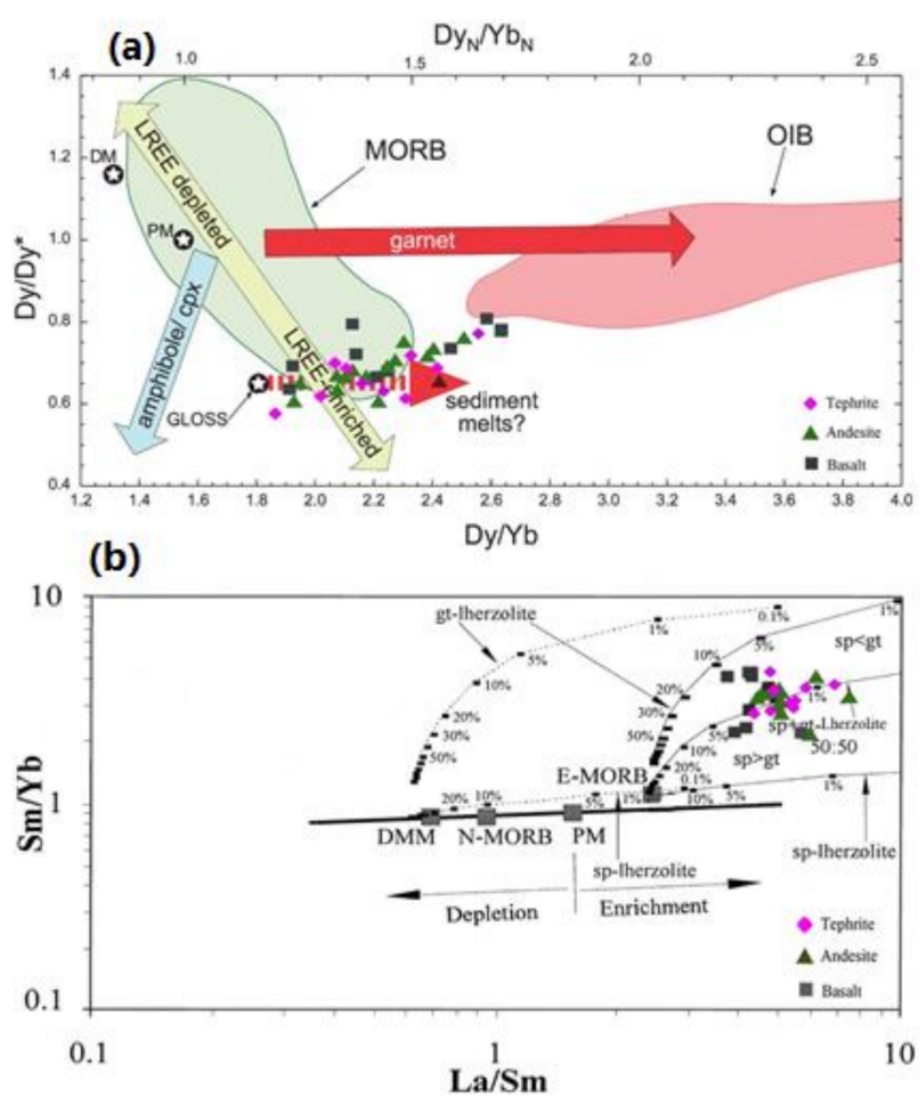
Figure 12. ( a ) Plot of Dy/Dy* vs. Dy/Yb with extended Dy/Yb scale to show fields for MORB and OIB of [98]. The OIB field extends to a much higher Dy/Yb (Samoa Dy/Yb as high as 12),